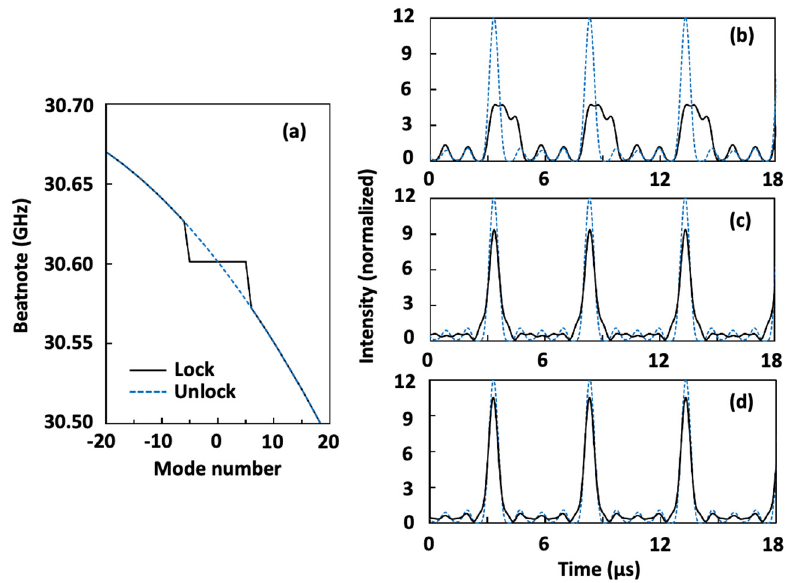
Figure 3. ( a ) Beat-note showing a lock band for modes − 5 ≤ n ≤ 5 with locking coefficient b = 5.0 MHz and dispersion from GaAs [24]. The dashed curve shows the beat-notes with b = 0. ( b ) Intensity ( | ∑ n E n cos [ ψ n ( t )] | 2 ) versus time showing progression towards transform-limited pulse train (blue dotted curves) with b increasing from 5 MHz to ( c ) 6 MHz and ( d ) 7